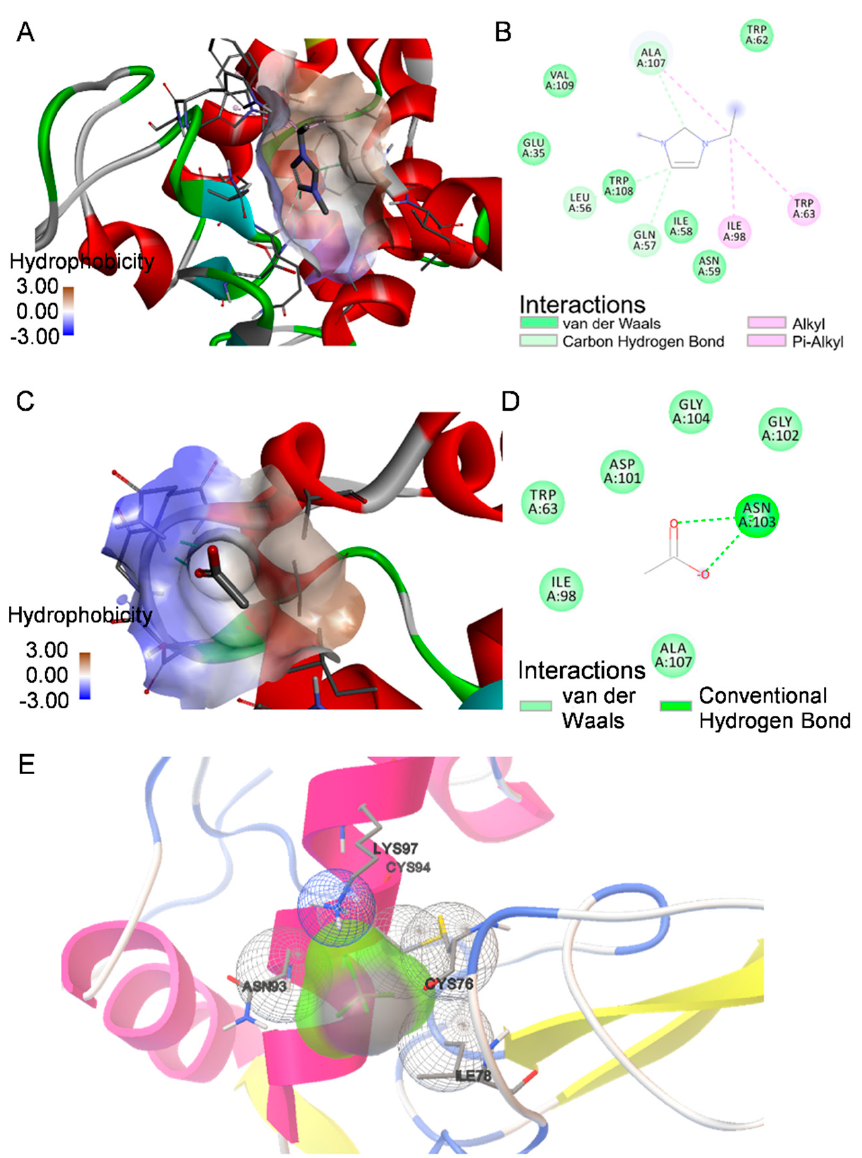
Figure 5. Hydrophobicity of amino acids residues on docking pose of lysozyme with ( A ) EMIM cation; ( C ) acetate anion. Molecular interaction diagrams of ( B ) EMIM cation and ( D ) acetate with amino acids residues of lysozyme. ( E ) Molecular interaction diagram of tetrafluoroborate anion (grey and green ball) to lysozyme from AutoDock